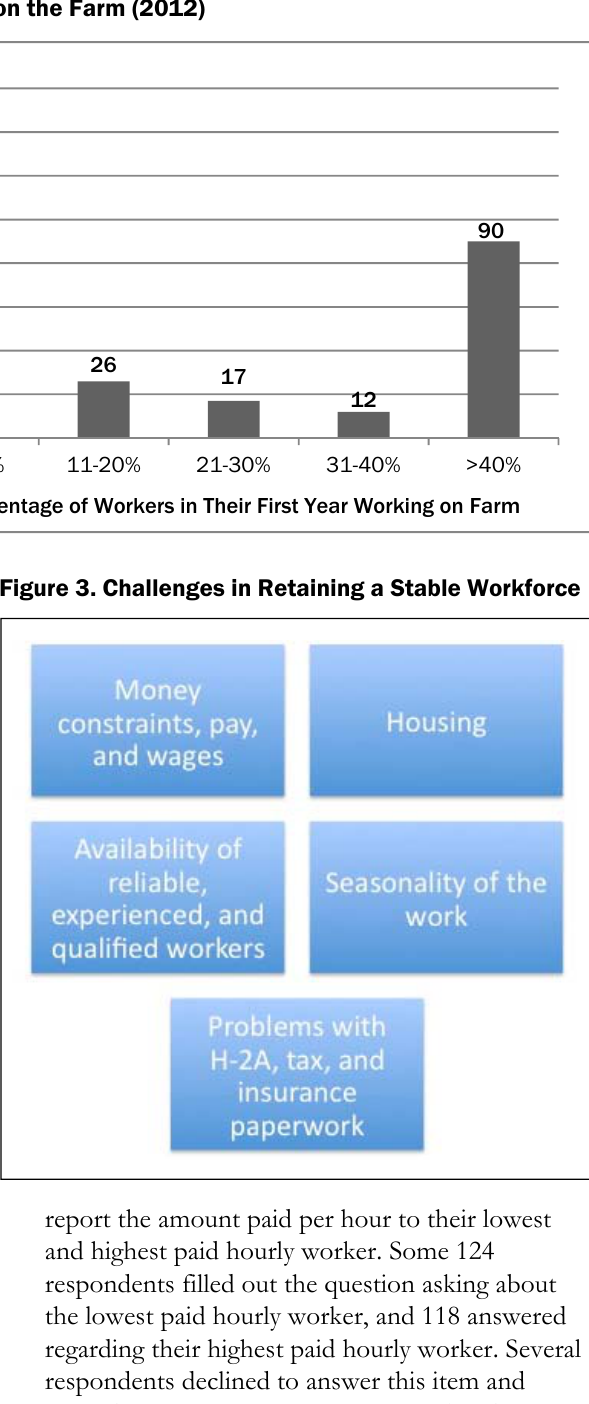
Figure 2. Farmers’ Reported Percentage of Workers in Their